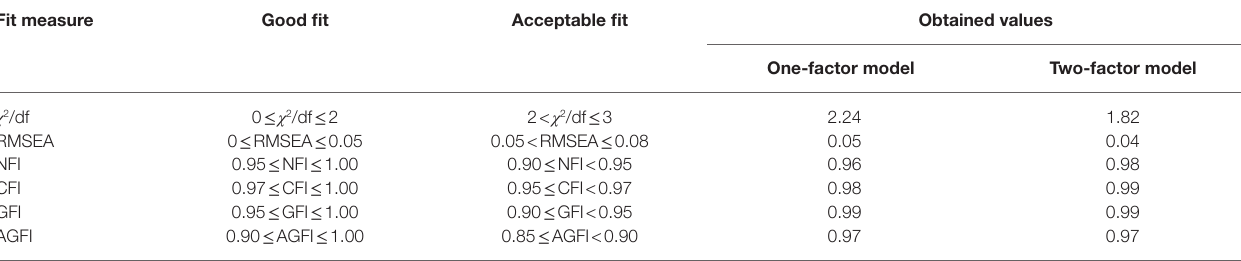
TABLE 2 | Recommended values for evaluation and the obtained